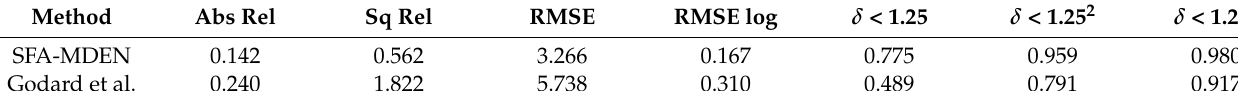
Table 5. Monocular depth estimation evaluation on the BHDE-v1 of SFA-MDEN and the model in Godard et al. [29].